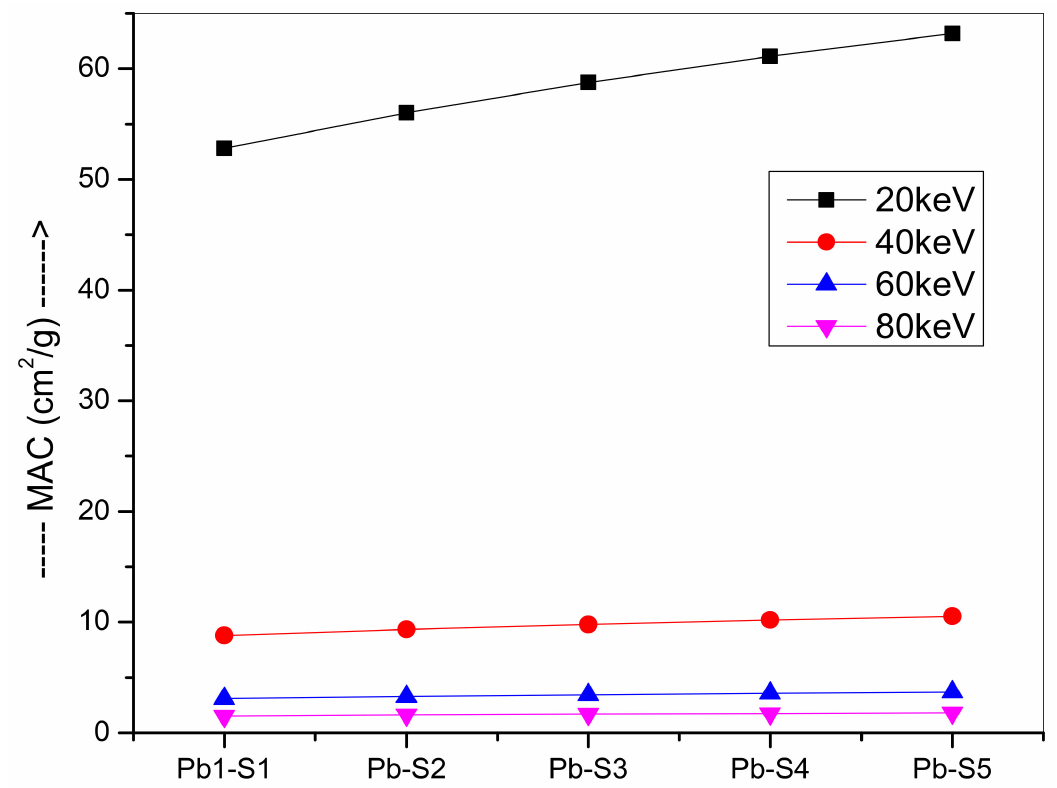
Figure 4. The MAC for the Pb-SX glasses at four energies (20, 40, 60 and 80 keV).